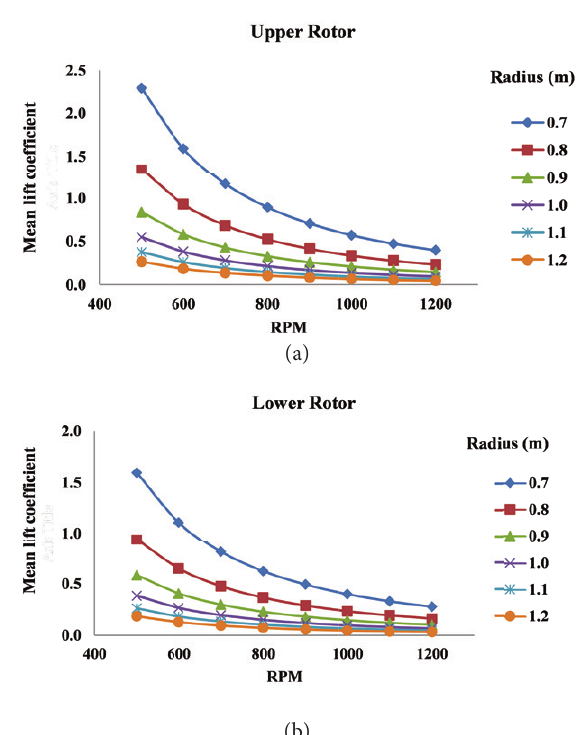
Figure 4. l C – n relation for 2-blade 2 rotor at various radiuses for upper and lower